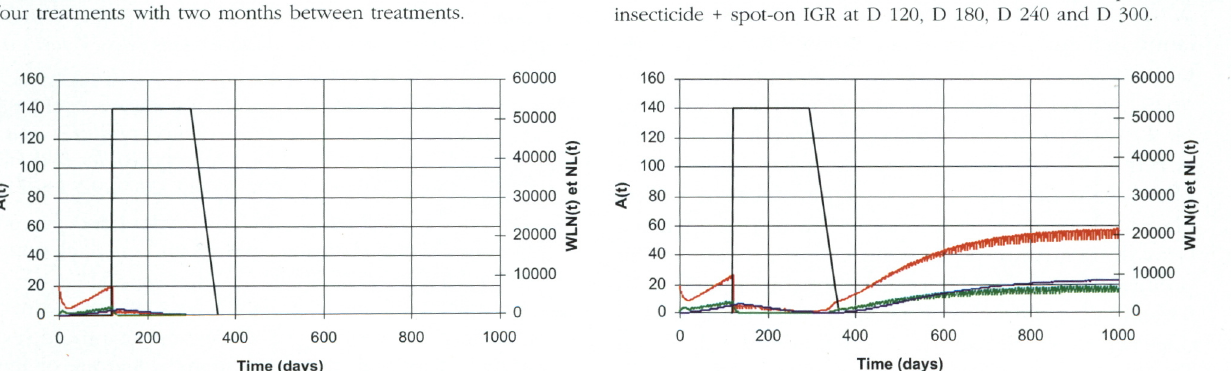
Fig. 19. - Treatment of host animal combining persistent insecticide and topical (spot-on) IGR at D 120, D 180, D 240 and D 300, i.e. four treatments with two months between treatments.